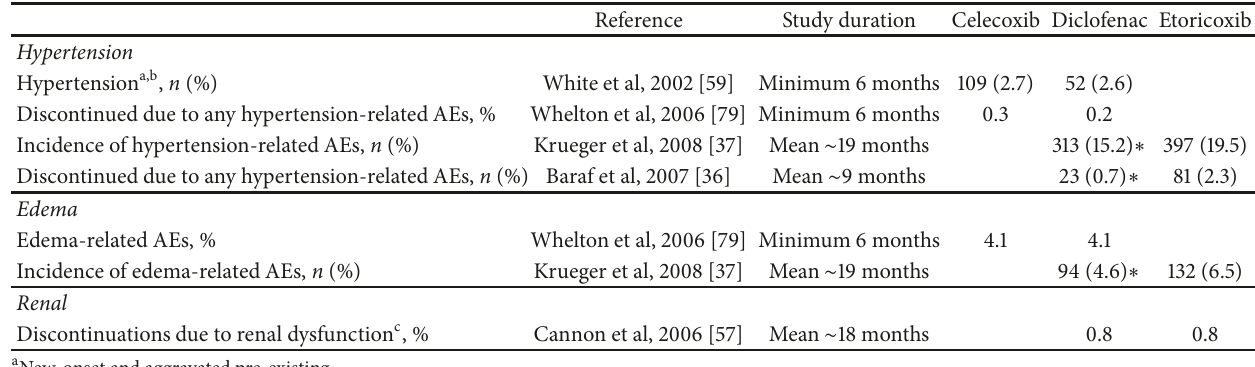
Table 5: Renal safety of celecoxib and etoricoxib compared with diclofenac in patients with OA and RA in randomized controlled trials.